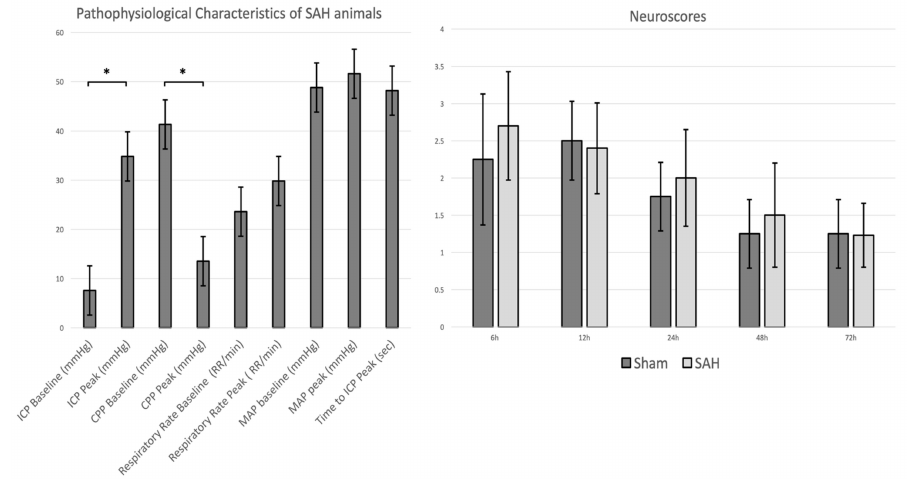
Figure 1. Pathophysiological characteristics of SAH animals (left panel) representing the changes of intracranial pressure (ICP), cerebral perfusion pressure (CPP), respiratory rate, and middle arterial pressure (MAP) at baseline (before SAH induction) and at peak (after SAH induction). Note, between baseline and peak there was a statistically significant increase of ICP and decrease of CPP, respectively. Data are presented as mean ± SD, *: p < 0.05. The right panel shows the neuroscores of the rabbits assessed at 6, 12, 24, 48, and 72 h after the surgical interventions. The SAH animals showed a tendency of worse neurological scores as compared to rabbits in the sham group ( p =